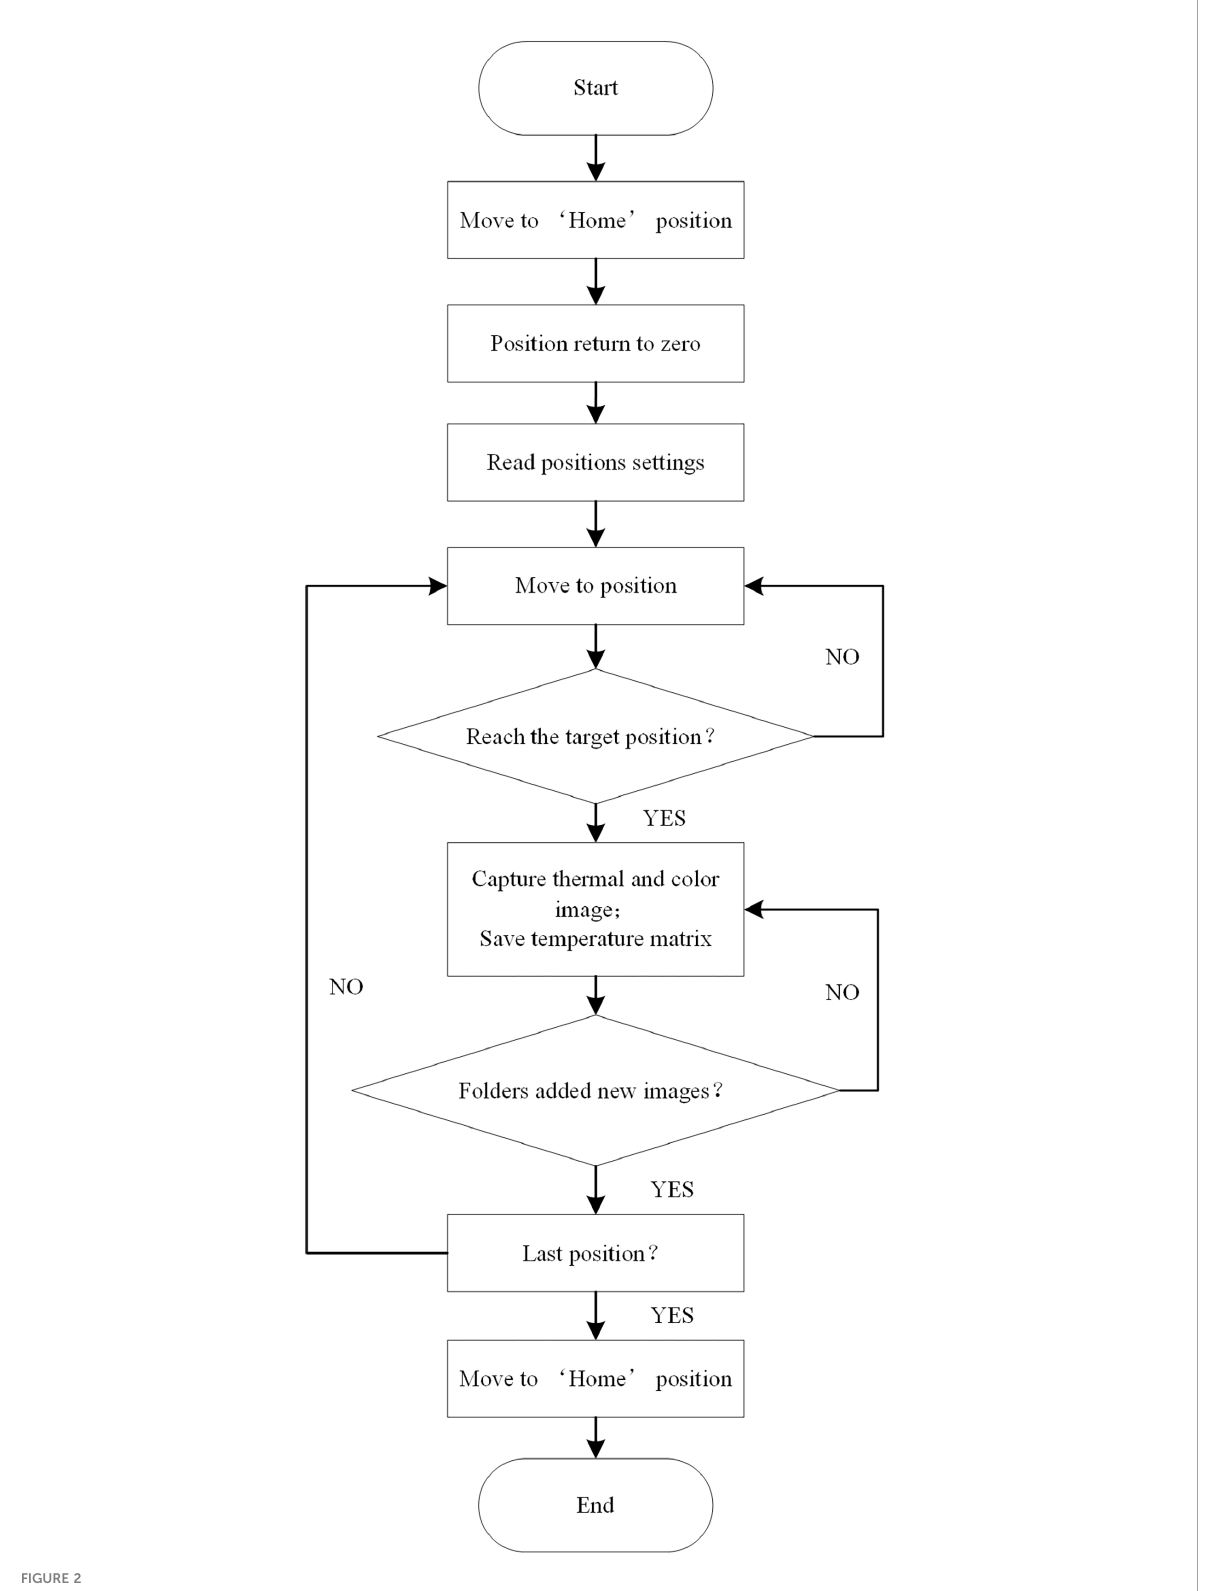
FIGURE 2 Work fl ow chart of the 3D robot